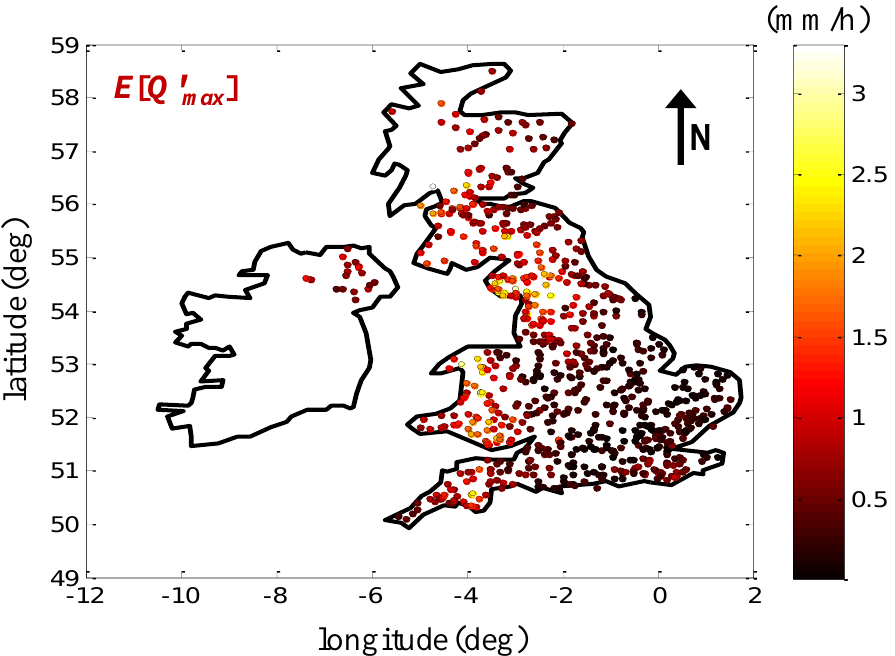
Figure 2. Spatial distribution of the mean value of the standardized discharge maxima 𝑄 𝑚𝑎𝑥′ = 𝑄 𝑚𝑎𝑥 ∕ 𝐴 .